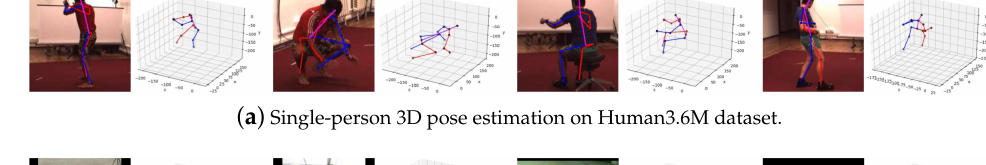
( a ) Single-person 3D pose estimation on Human3.6M dataset.